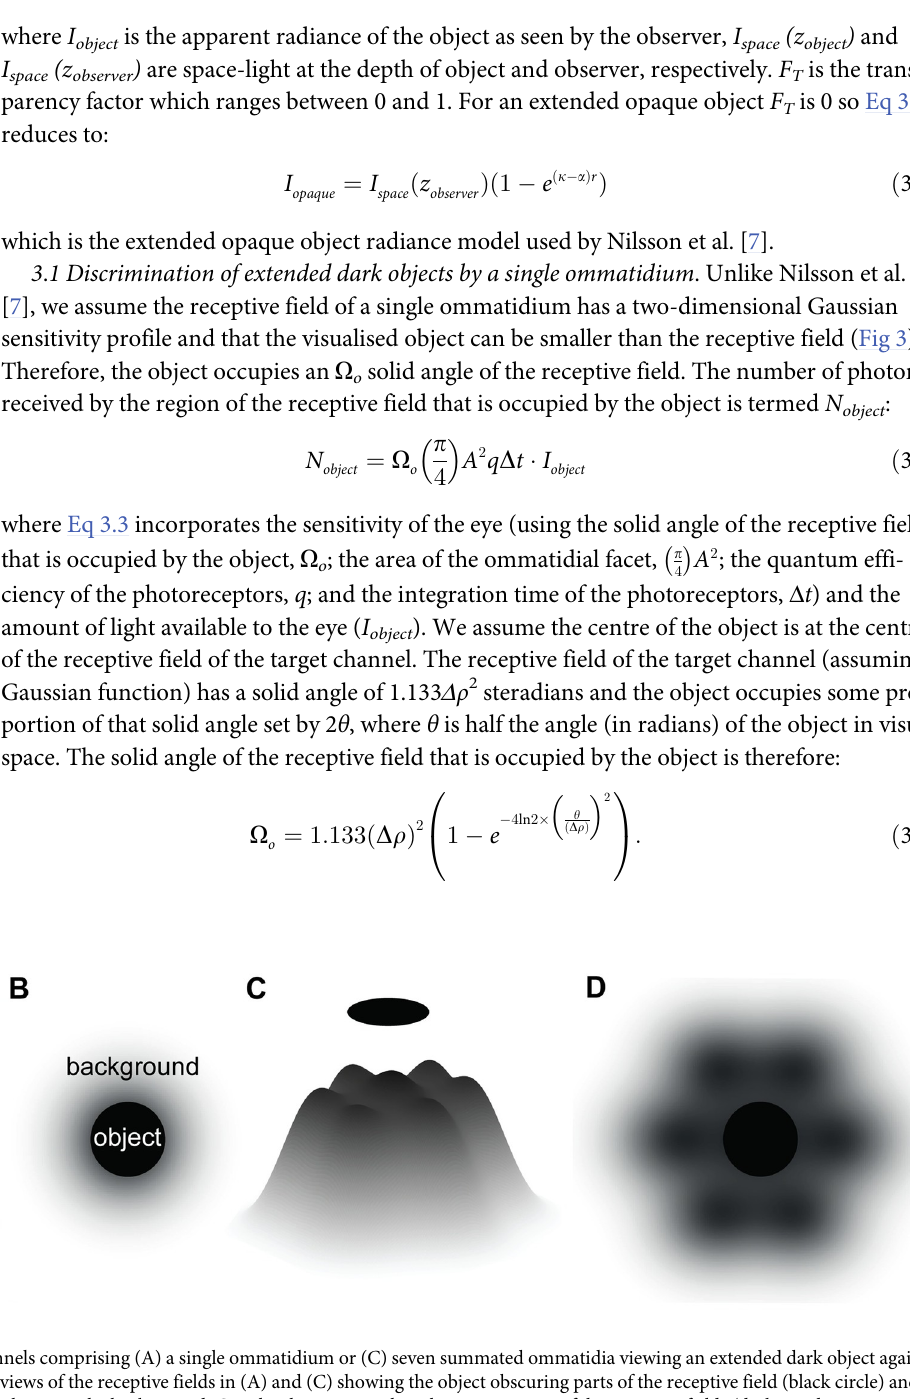
PLOS Computational Biology | https://doi.org/10.1371/journal.pcbi.1010545 October 17,